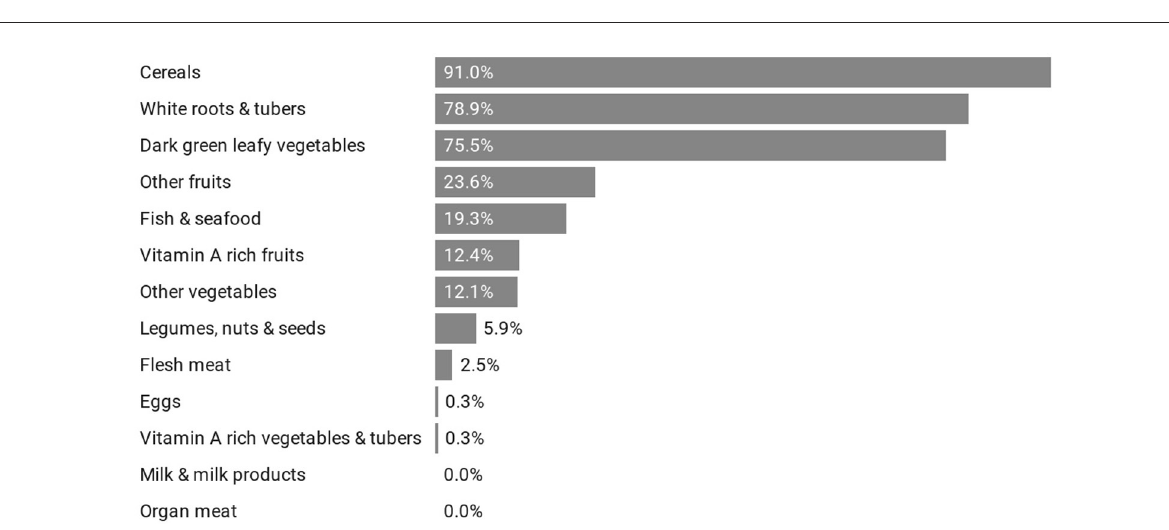
FIGURE5 Percentage of respondents consuming foods from each food group ( n =